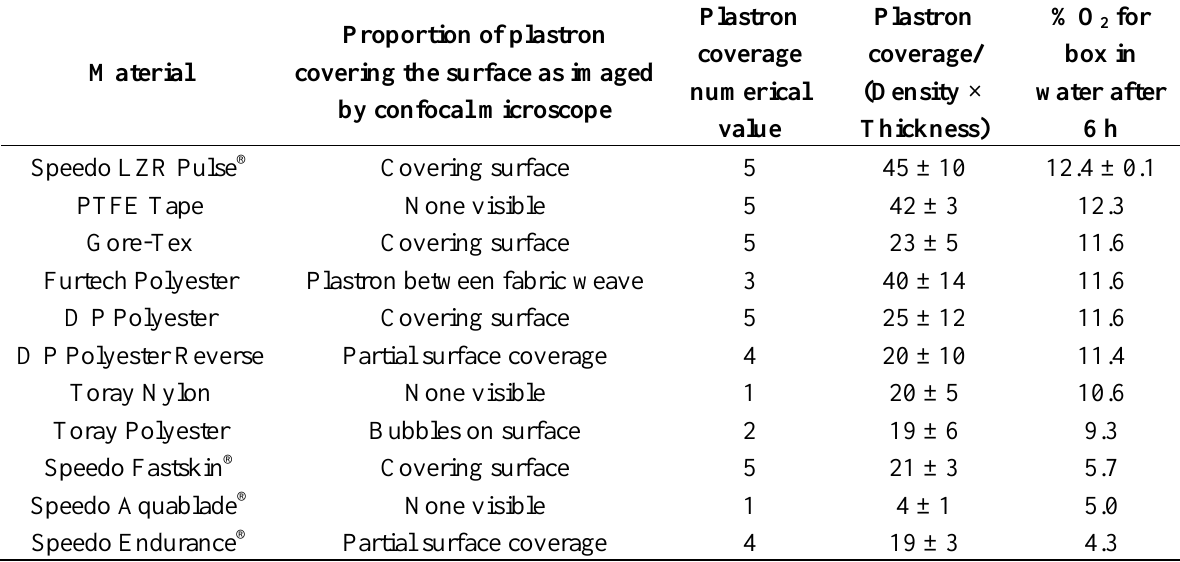
Table 2. Values for the plastron coverage of the samples, the plastron coverage/(density × thickness) values and the %O levels in the box after 6 h 2